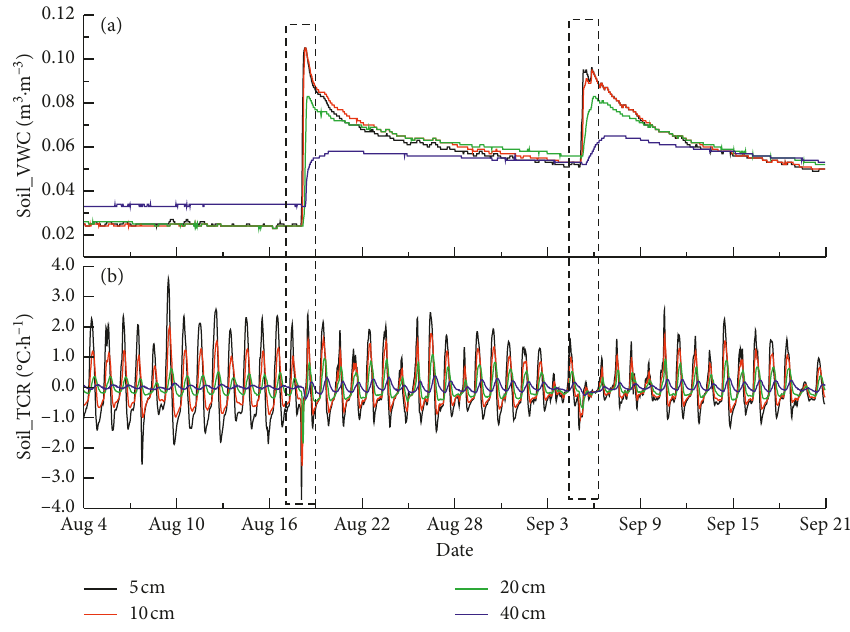
Figure 3: Variations in ST and VWC before and after rainfall: (a) VWC and (b)